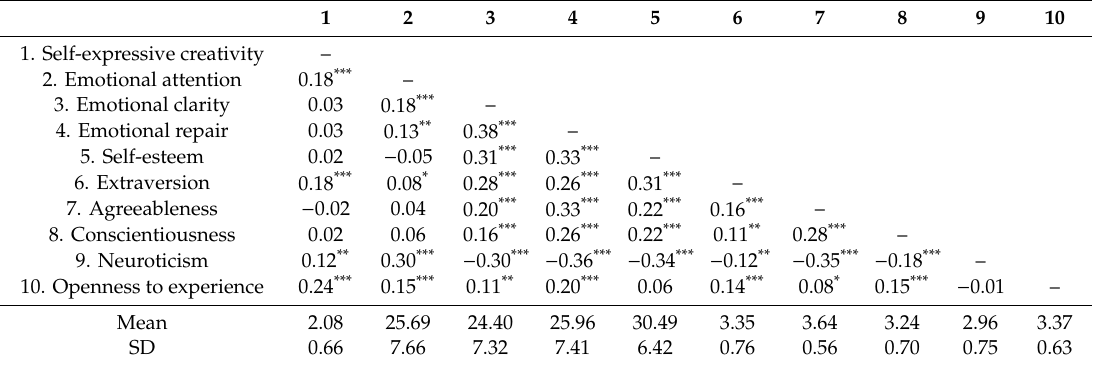
Table 1. Correlations and descriptive statistics: self-expressive digital creativity, emotional intelligence (EI), self-esteem, and